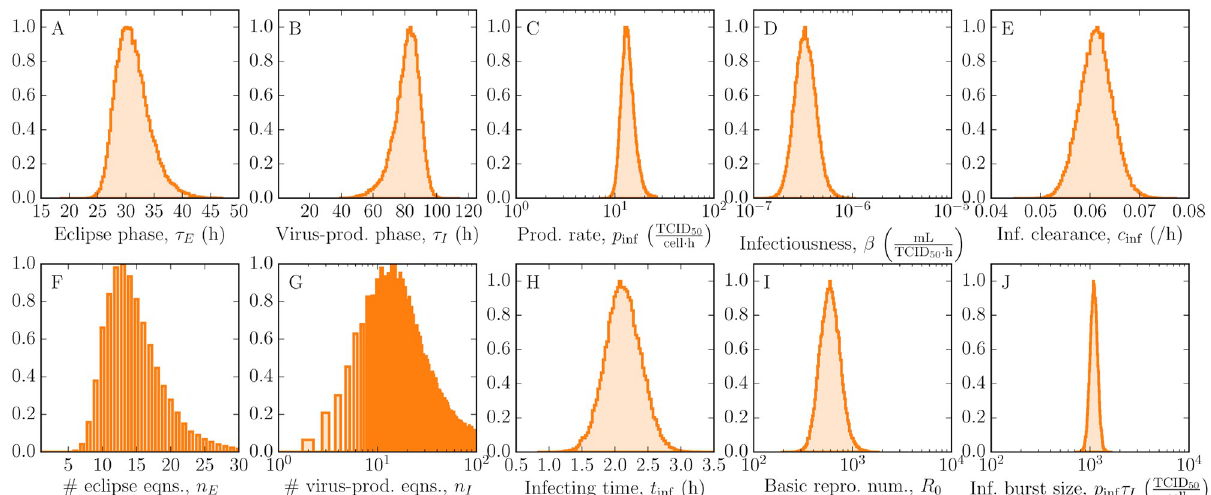
Fig 2. Estimated parameter distributions of EBOV infection in vitro . Posterior probability likelihood distributions (PostPLDs) of parameters in the MM (A–G) were estimated using MCMC and the data in Fig 1. Secondary parameters were derived from these estimates (H–J). Note that the PostPLDs corresponding to the number of eclipse and infectious phase compartments are integer-valued. The remaining PostPLDs of parameters describing the total virus and calibration curve are in S1 Appendix, Fig. B.